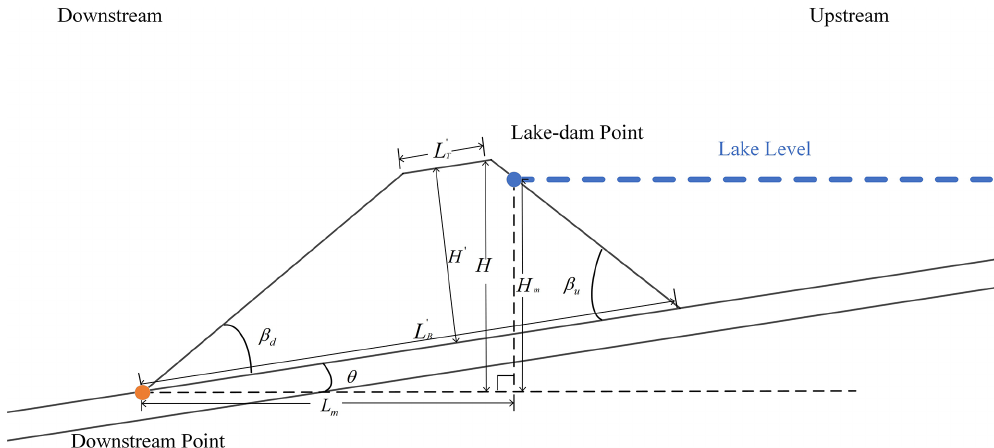
Figure 3. Simplified section of the landslide